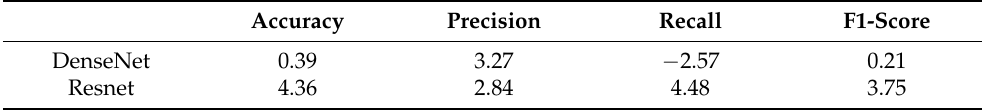
Table 3. Difference in percentage of Blended CNN and single